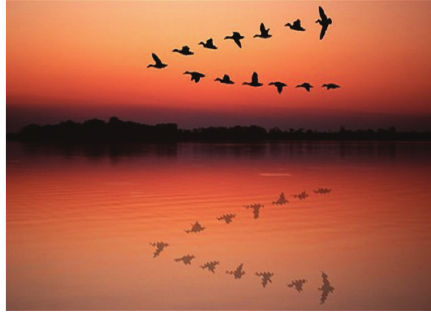
Figure 1: V-formation in birds. Source: [9].